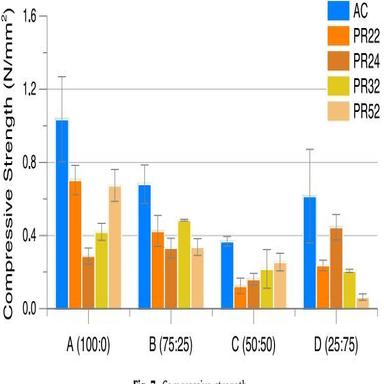
Compressive strength.